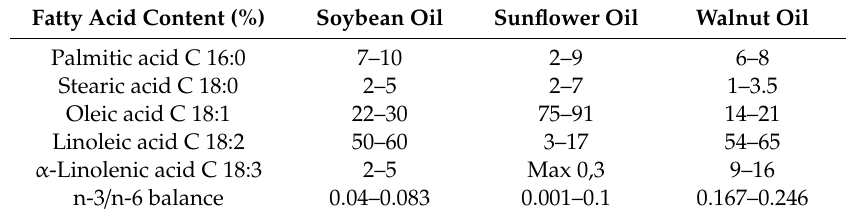
Figure 1. Scheme showing the experimental design of this study. Table 1. Composition of fatty acids in diets used for